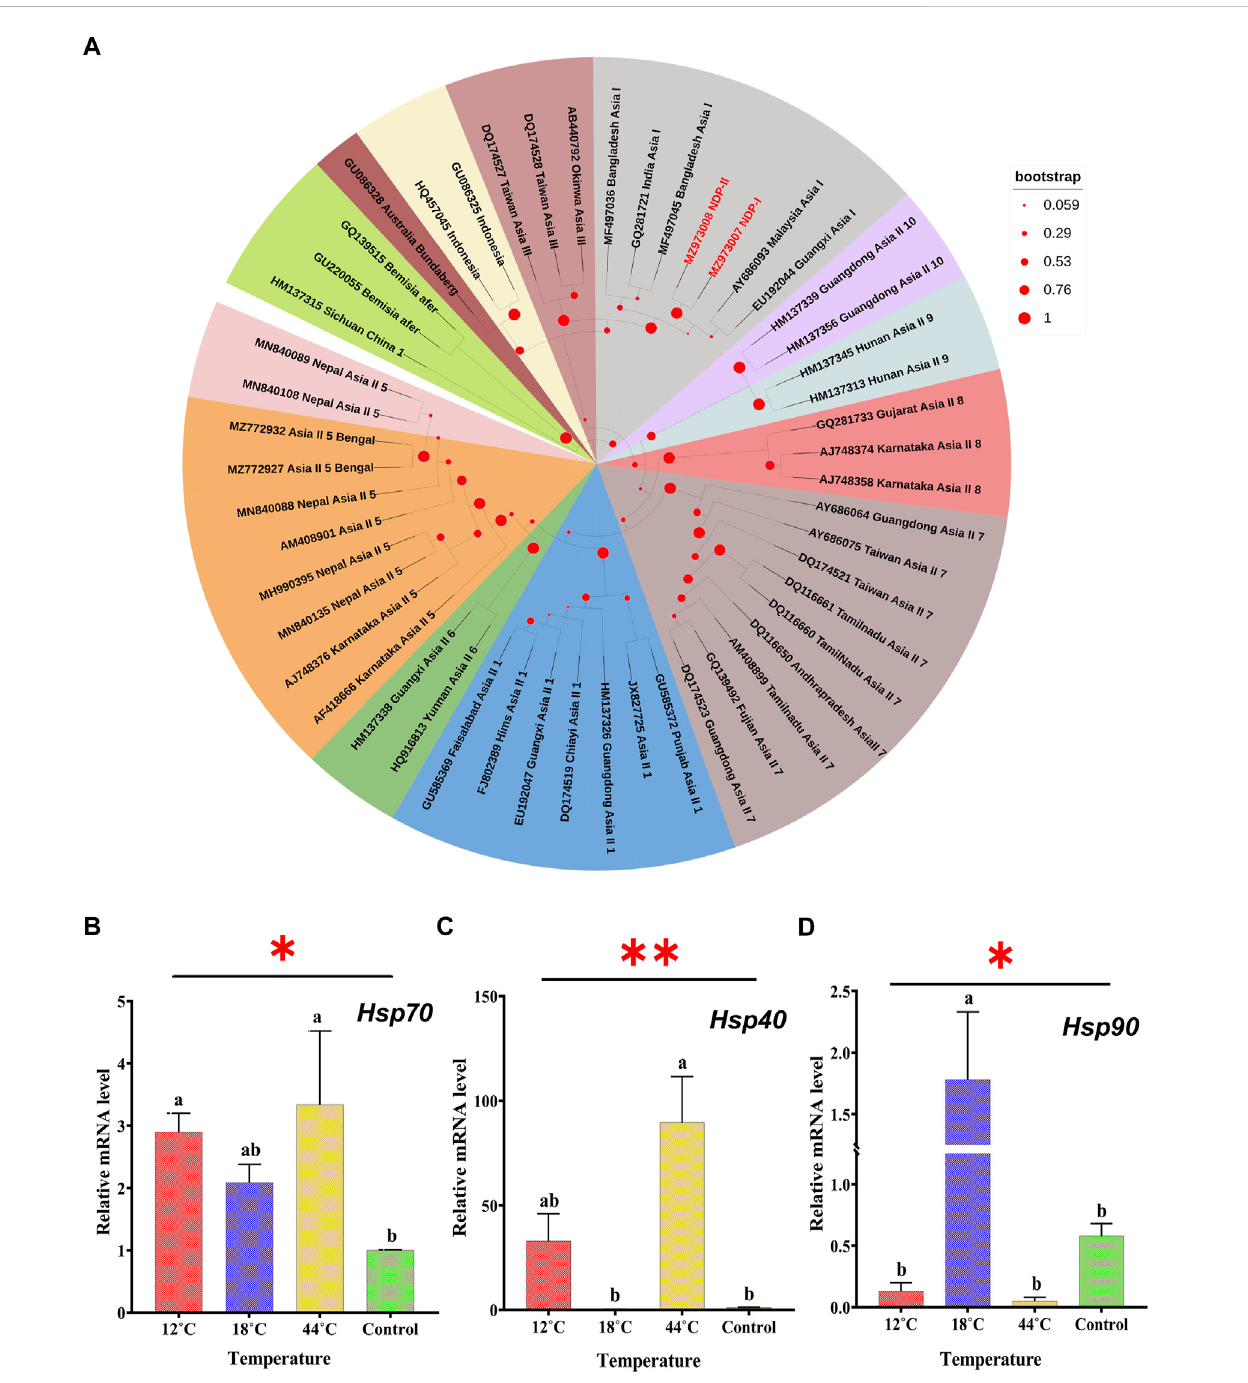
FIGURE 2 (A) Phylogenetic tree of B . tabaci cryptic species is identi fi ed based on cytochrome oxidase subunit I (COI) sequences. The samples from the study are indicated by bold text (red) in the tree; all other sequences were obtained from the GenBank database. Bemisia afer sequences were taken as an out-group. Effect of thermal stress (12 ° C, 18 ° C, 26 ° C, and 44 ° C) on the transcript level of Hsp70 (B) , Hsp40 (C) , and Hsp90 (D) . Adult white fl y exposed to 26 ° C was considered as control. Relative mRNA expression levels measured by qRT-PCR with β - actin are used as a reference gene. The different letters indicate statistically signi fi cant differences between the treatments. p ≤ 0.05 is indicated by *, and p ≤ 0.01 is indicated by